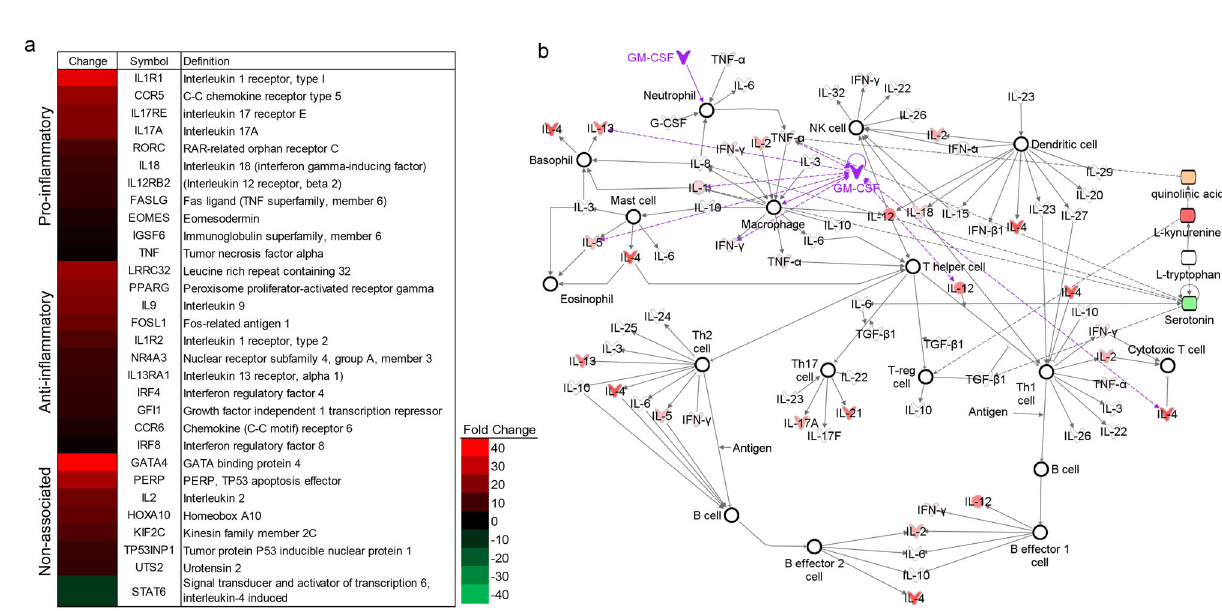
Fig. 3 T cell gene expression analyses of T cells from sargramostim-treated or placebo-treated PD patients. a Signi fi cant increase or decrease in expression of genes by CD4+CD25 − T cells from PD patients treated with sargramostim compared with placebo. Genes are divided into those associated with Th1 and Th17 (Pro-in fl ammatory), Th2 and Tregs (Anti-in fl ammatory), and general T cell proliferation and differentiation (Non-associated). Signi fi cant differences are indicated by a heat map. The map ranged from 40-fold increase ( red ) to 40-fold decrease ( green ). b Ingenuity pathway analyses performed on upregulated or downregulated genes to identify putative network associations involved in hematological development and T cell function. Genes and mediators that are upregulated are shaded red with the darker shades indicating more upregulation; shades of green denote downregulation; and nodes in white represent putative-associated